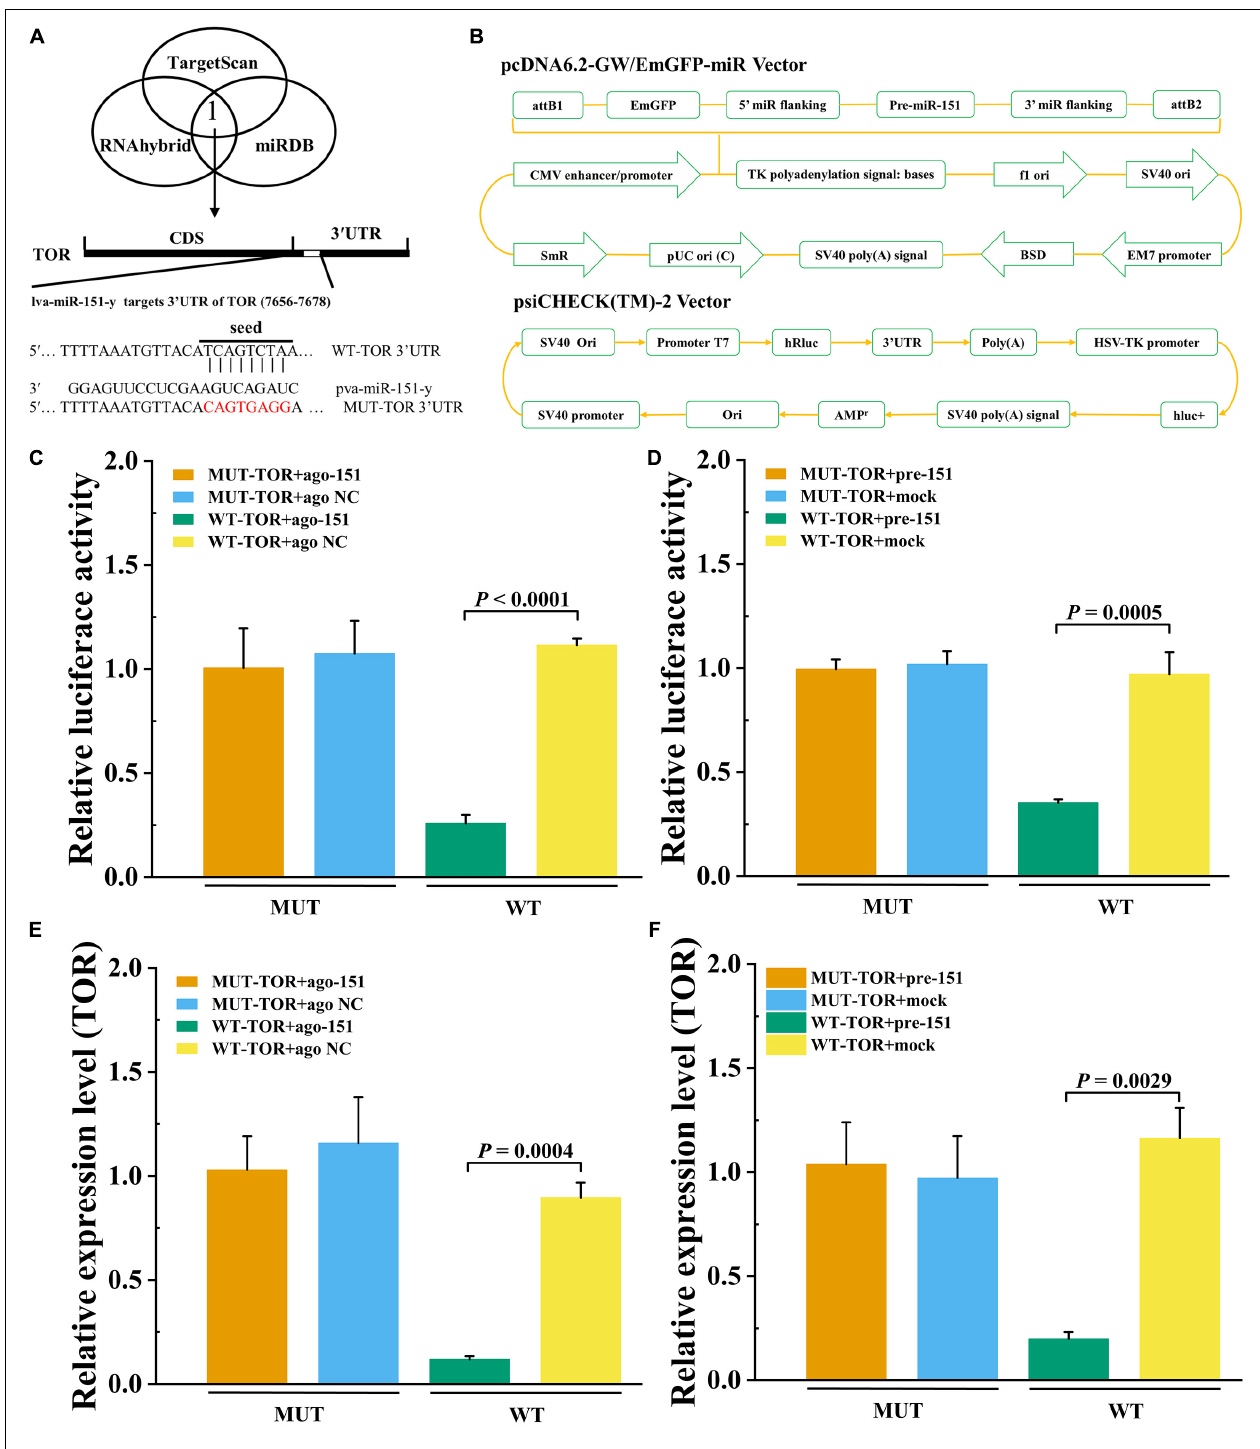
FIGURE 8 | Prediction and validation of pva-iR-151 target genes PvTOR . (A) Predicted target genes of pva-miR-151. The 3 (cid:48) -UTR of the PvTOR gene was predicted to be targeted by miR-13b used TargetScan, miRDB, and RNAhybrid. Schematic diagram miR-151 to binding 3 (cid:48) -UTR of PvTOR and wild or mutant type 3 (cid:48) -UTR of PvTOR. (B) Schematic diagram of pcDNA-pre-miR-151 and psiCHECK-3 (cid:48) -UTR PvTOR vector. The luciferase activity was determined using reporter gene assay. Data were shown as fold changes and mean ± SD. Primary cells were transfected with ago-151 (C) or pcDNA-pre-miR-151 (D) and psiCHECK-3 (cid:48) -UTR PvTOR cotransfection with Lipofectamine 2000. After incubation at 27 ◦ C for 24 h, the luciferase activity was determined. The mTOR expression levels after primary cells were transfected with ago-151 (E) or pcDNA-pre-miR-151 (F) . Data were shown as fold changes and mean ± SD.